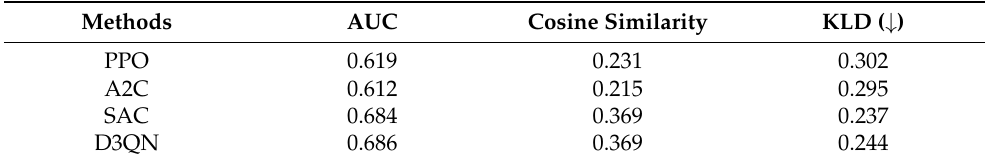
Table 4. Quantitative results for the decision-making framework in our dataset using different reinforcement learning methods. A higher AUC value or cosine similarity value indicate a better performance. Smaller KLD values indicate better performance.